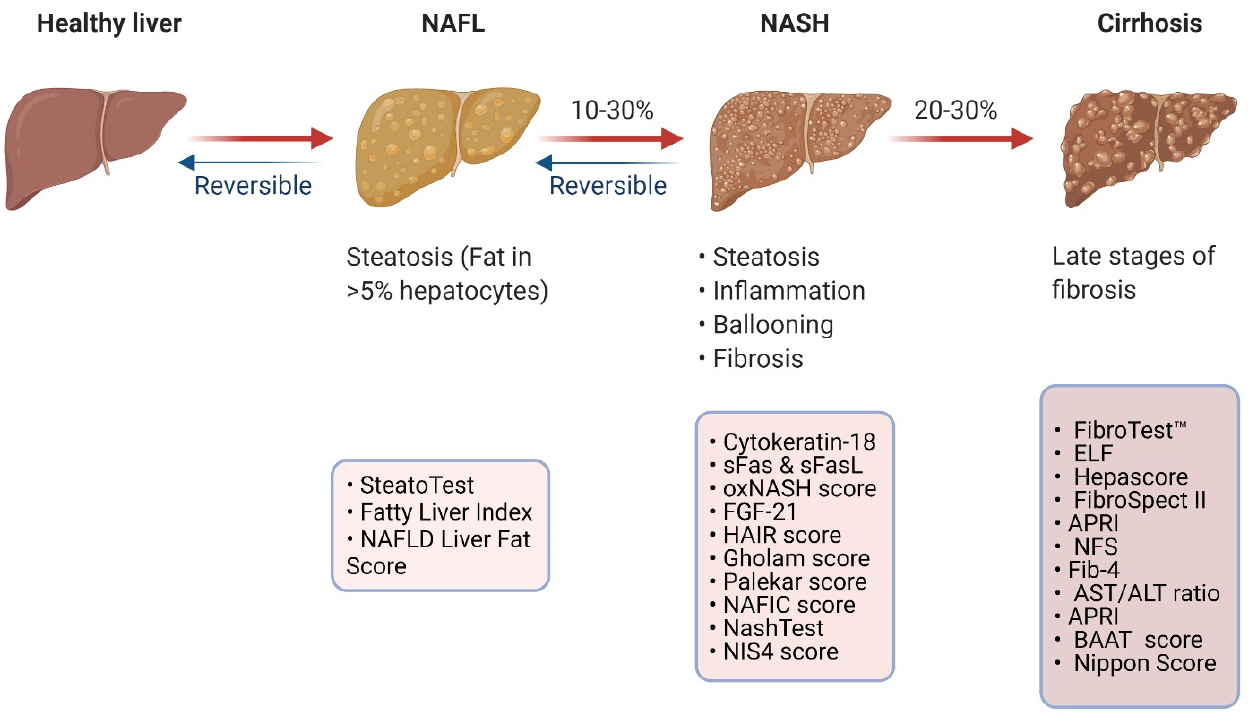
Figure 1. Overview of biochemical indices and diagnostic models discussed in the paper (created with BioRender.com, accessed on 21 December 2021). APRI: AST/PLT ratio index, ALT: Alanine aminotransferase, AST: Aspartate aminotransferase: BAAT: Body mass index, age, ALT and triglyc- erides, ELF: European Liver Fibrosis panel, FGF-21: Fibroblast growth factor 21, HAIR: Hypertension, ALT and insulin resistance NAFL: Non-alcoholic fatty liver, NAFLD: Non-alcoholic fatty liver disease, NASH: Non-alcoholic steatohepatitis, NAFIC: Ferritin, insulin and collagen NFS: NAFLD Liver Fat Score, sFas: Soluble Fas, sFasL: Fas ligand.